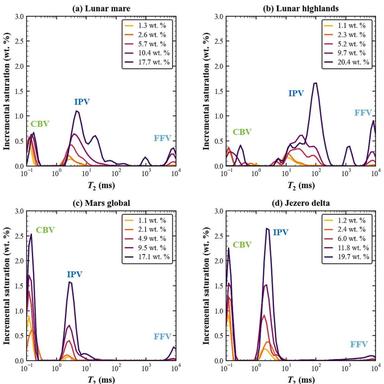
Progressive saturation of the regolith simulant samples. Water is incrementally added to samples and multi-TE measurements are captured at each saturation state. The T2 distributions are determined as the projected distribution of the 2D T2-geff distributions. Measurements are conducted for: (a) Lunar Mare, (b) Lunar highlands, (c) Mars global and (d) Jezero delta simulants. For each simulant, the final measurement is at the fully saturated state (corresponding to measurements in). The clay-boun